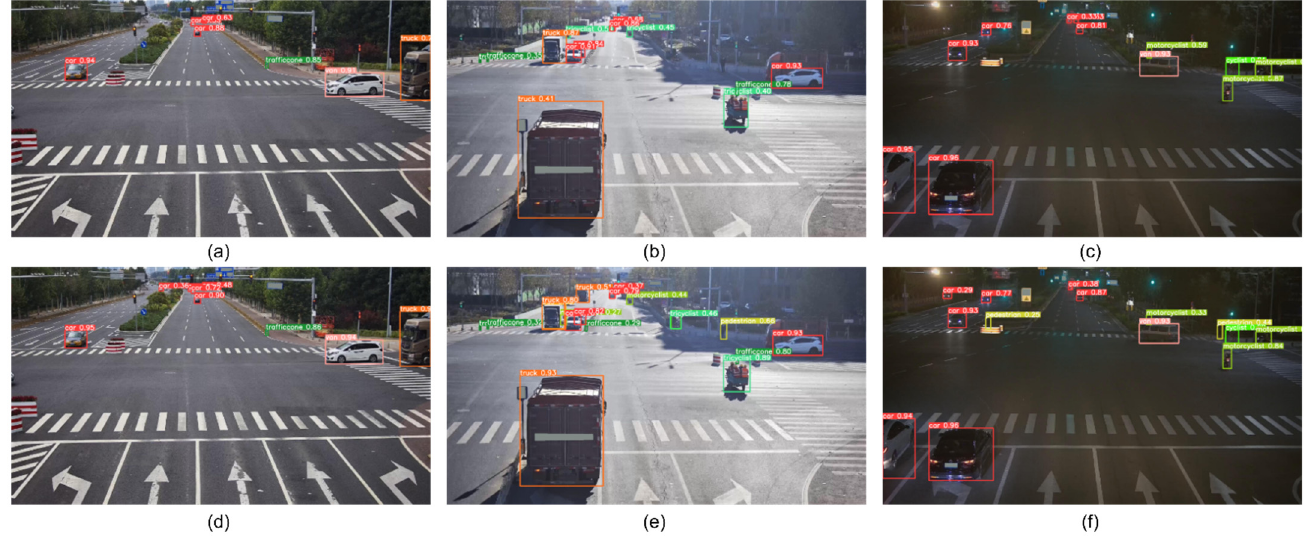
Figure 15. Visual comparison of YOLOv5s and RD-YOLO detection results on the Rop3D dataset. ( a ) YOLOv5s detection result of No. 1 image. ( b ) YOLOv5s detection result of No. 2 image. ( c ) YOLOv5s detection result of No. 3 image. ( d ) RD-YOLO detection result of No. 1 image. ( e ) RD-YOLO detection result of No. 2 image. ( f ) RD-YOLO detection result of No. 3 image.